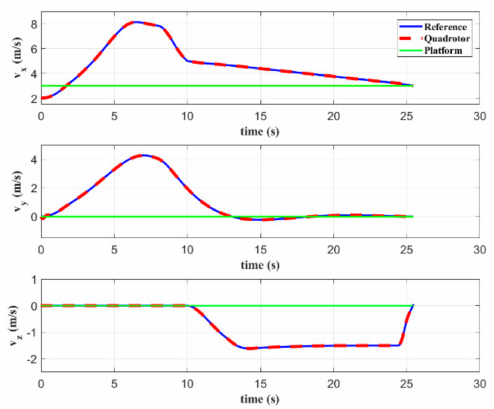
Figure 7. Velocities of the quadrotor and platform in simulation